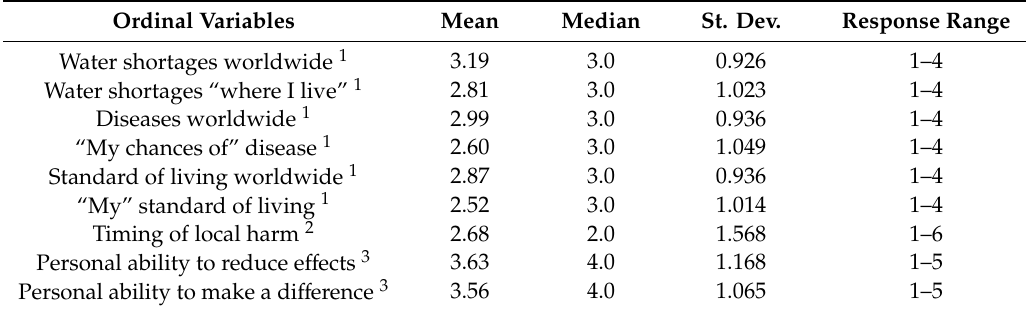
Table 2. Descriptive statistics for ordinal variables.